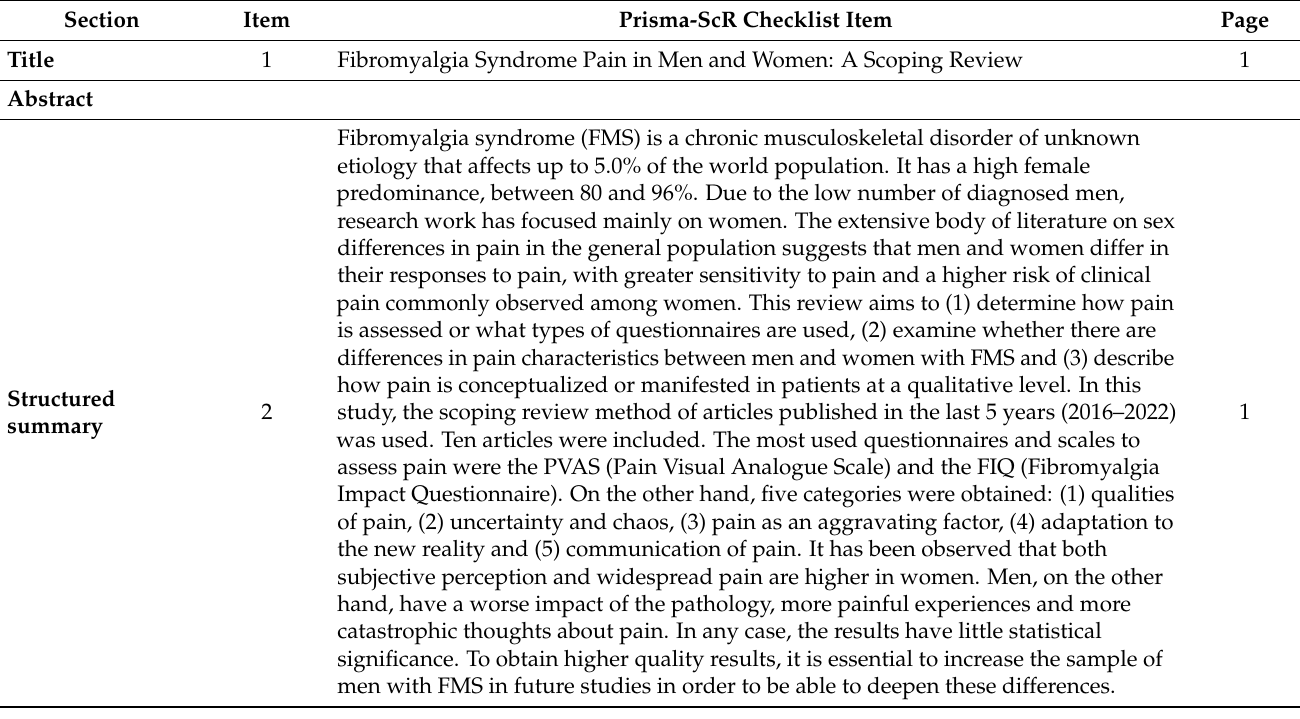
Table A1. Preferred Reporting Items for Systematic reviews and Meta-Analyses extension for Scoping Reviews (PRISMA-ScR)